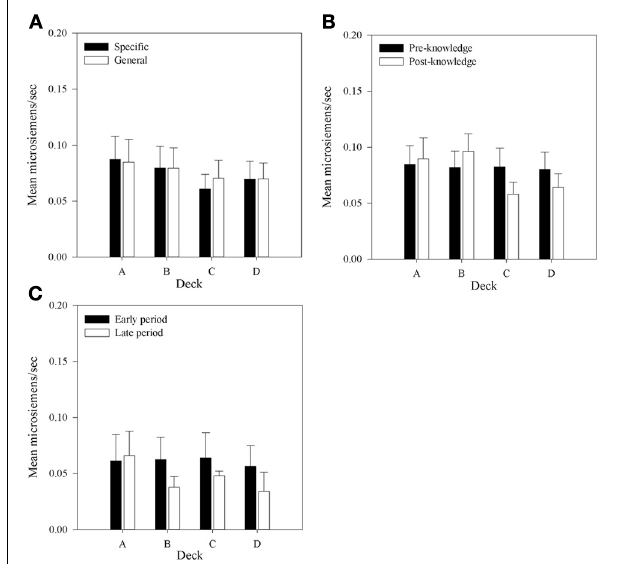
FIGURE 8 | Mean rSCRs for each deck in each group, (A) across all selections; (B) in selections prior to and following knowledge expression in those participants who displayed knowledge; and (C) the equivalent figure to b for participants who did not demonstrate knowledge—rSCRs before and after the mean trial at which knowledge was expressed in those who expressed knowledge (trial 39 in the Specific Group and trial 43 in the General group). Error bars are the standard error of the mean.